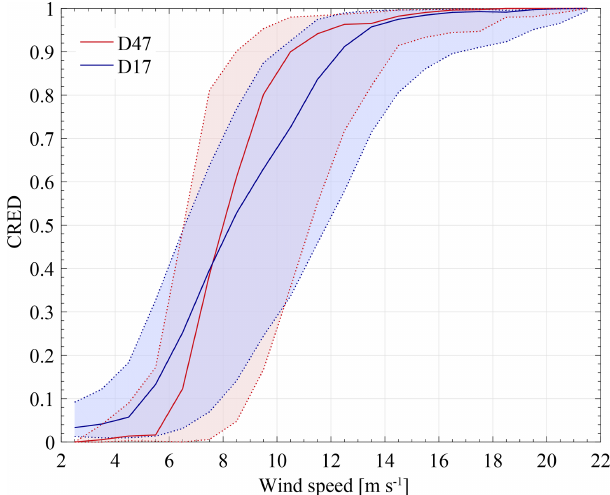
Figure 3. CRED distribution showing the increasing probability of observing drifting snow with increasing 2m wind speed at sites D47 (red curve) and D17 (blue curve). Shaded areas correspond to CREDs respectively computed using a relaxed and a stricter con- fidence threshold of 10 − 4 and 10 − 2 kgm − 2 s − 1 and are shown as a measure of